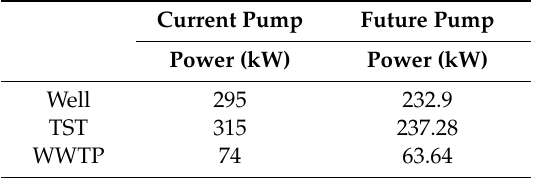
Table 1. Pumping equipment power comparison. Source: Own